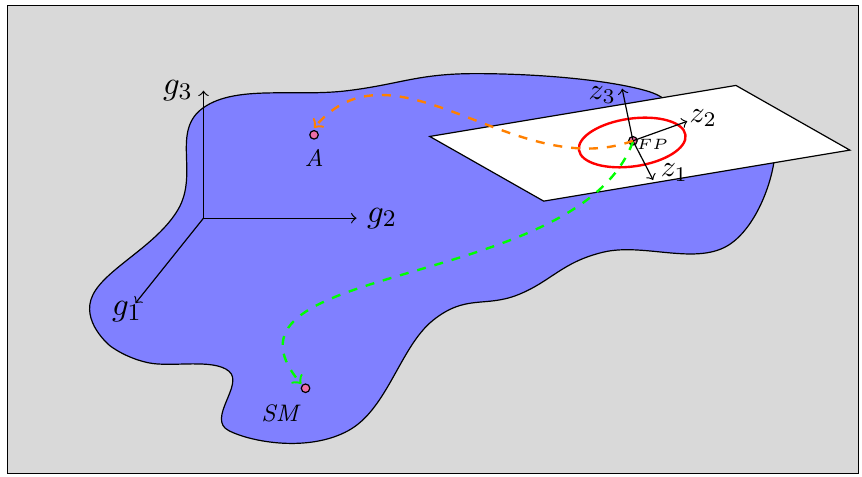
Figure 1 . Theory space of couplings g i where only 3 axes are shown for simplicity. For a given (cid:12)xed point we show the UV safe surface (blue region), the approximated UV critical surface around the (cid:12)xed point (white plane), the new set of coordinates z i , a small region of possible initial points for the (cid:13)ow (red circle) and two UV safe trajectories ending at a given matching scale M (green and orange dashed lines, the former going to the SM, the latter going to a di(cid:11)erent IR physics A).